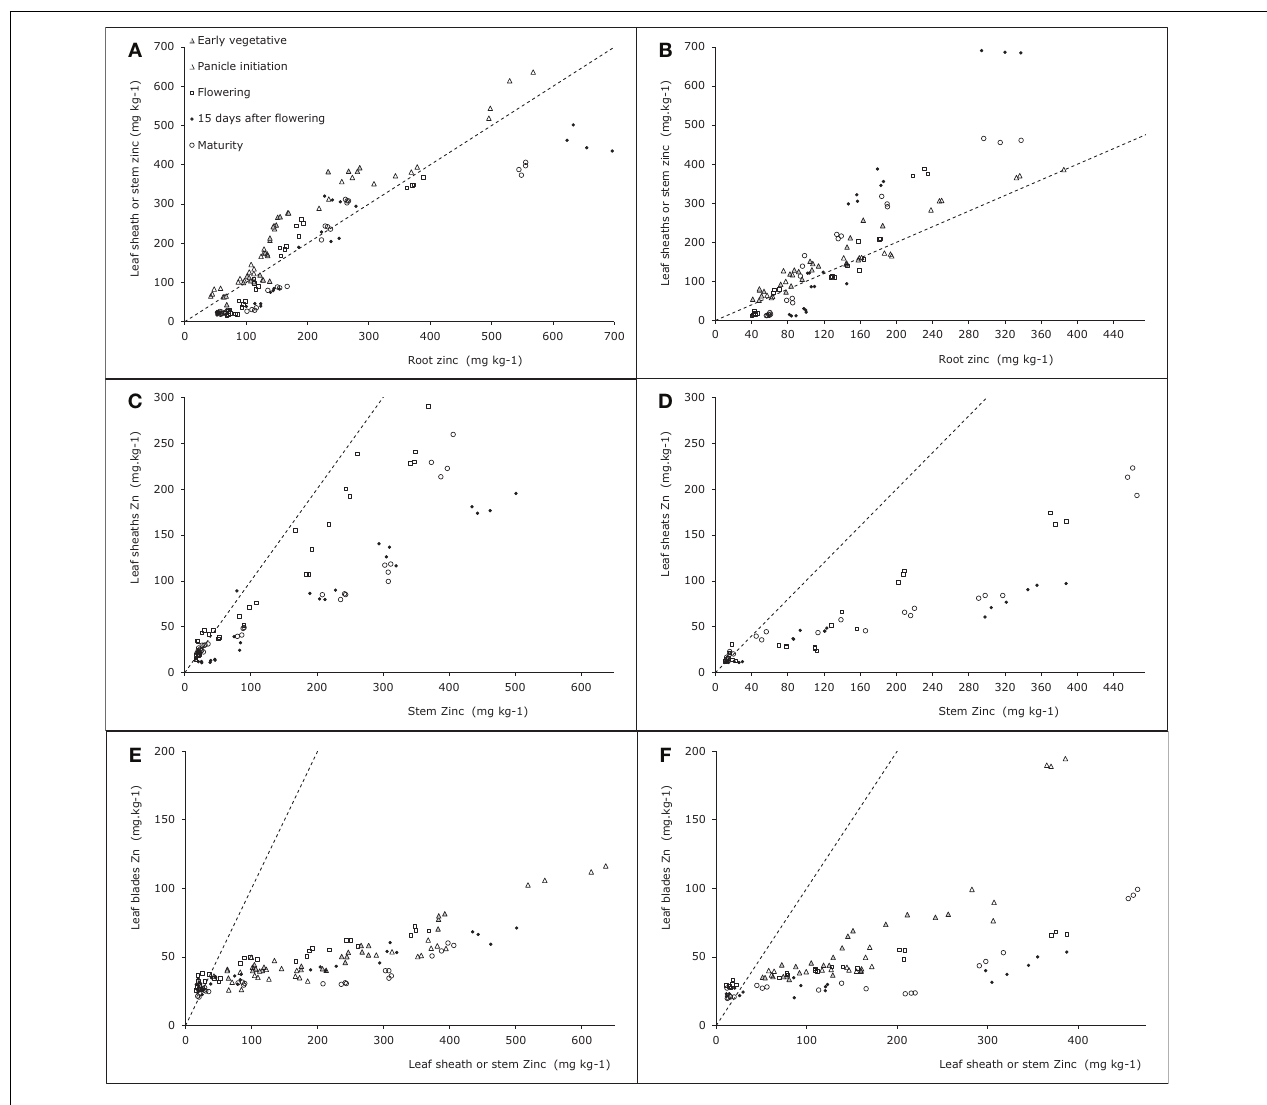
FIGURE 4 | Zinc concentrations in vegetative plant tissues as indicated along the axes for two rice genotypes tested in Experiment 4 [see also Jiang et al. (2008a)]. Panels (A) , (C) , and (E) are for Baxiludao, Panels (B) , (D) , and (F) for Handao 502. Data represent individual replications. The filled